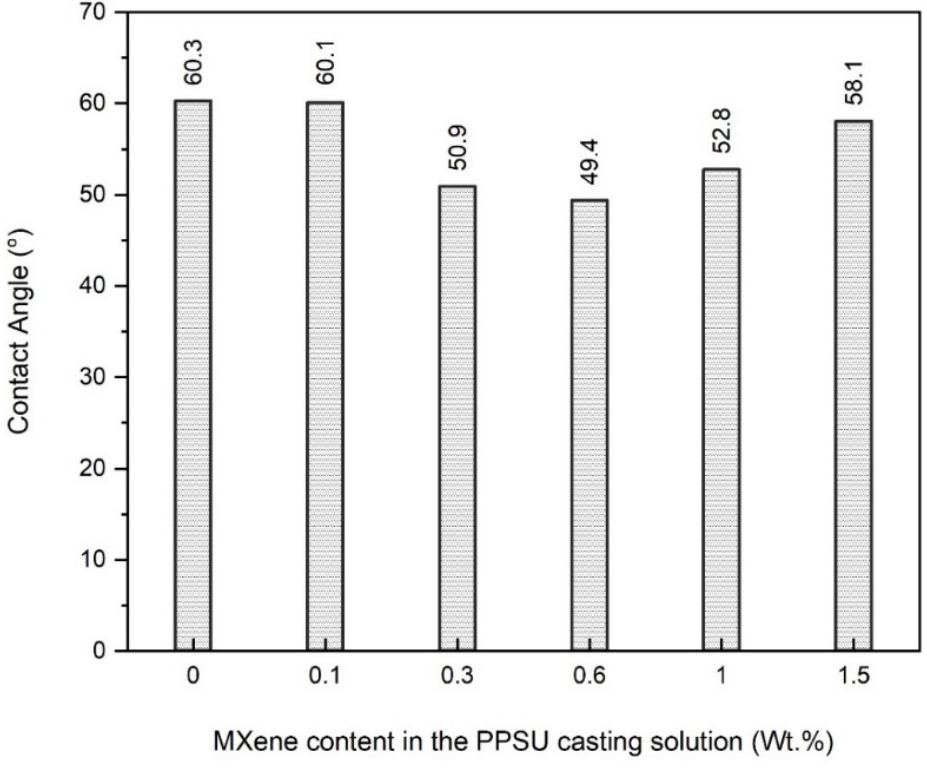
Figure 7. Contact angle measurement of the control and MXene-modi fi ed membranes.